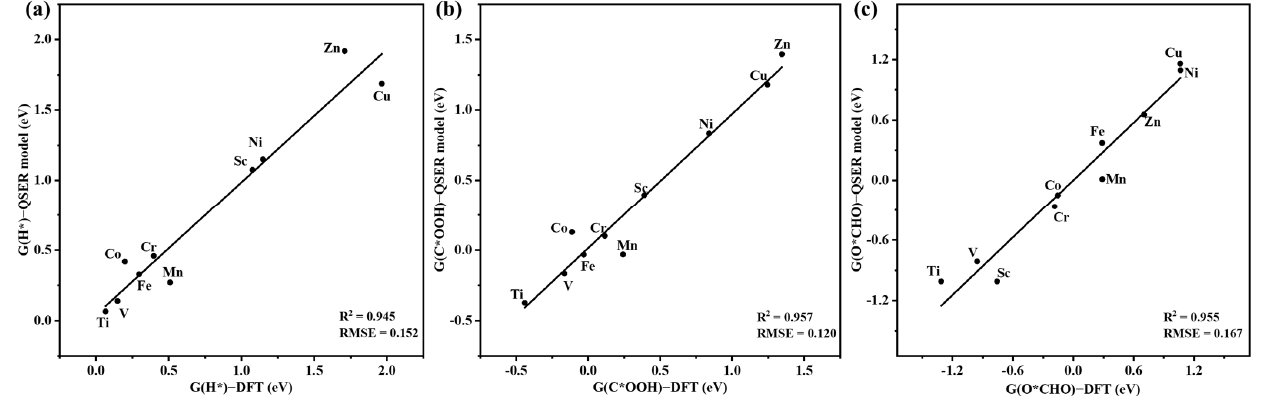
Figure 5. Plots of the QSER-model-predicted values versus the DFT-calculated values for ( a ) G(H*), ( b ) G(C*OOH), and ( c ) G(O*CHO) for the TM–PP catalysts using the GA–MLR method.